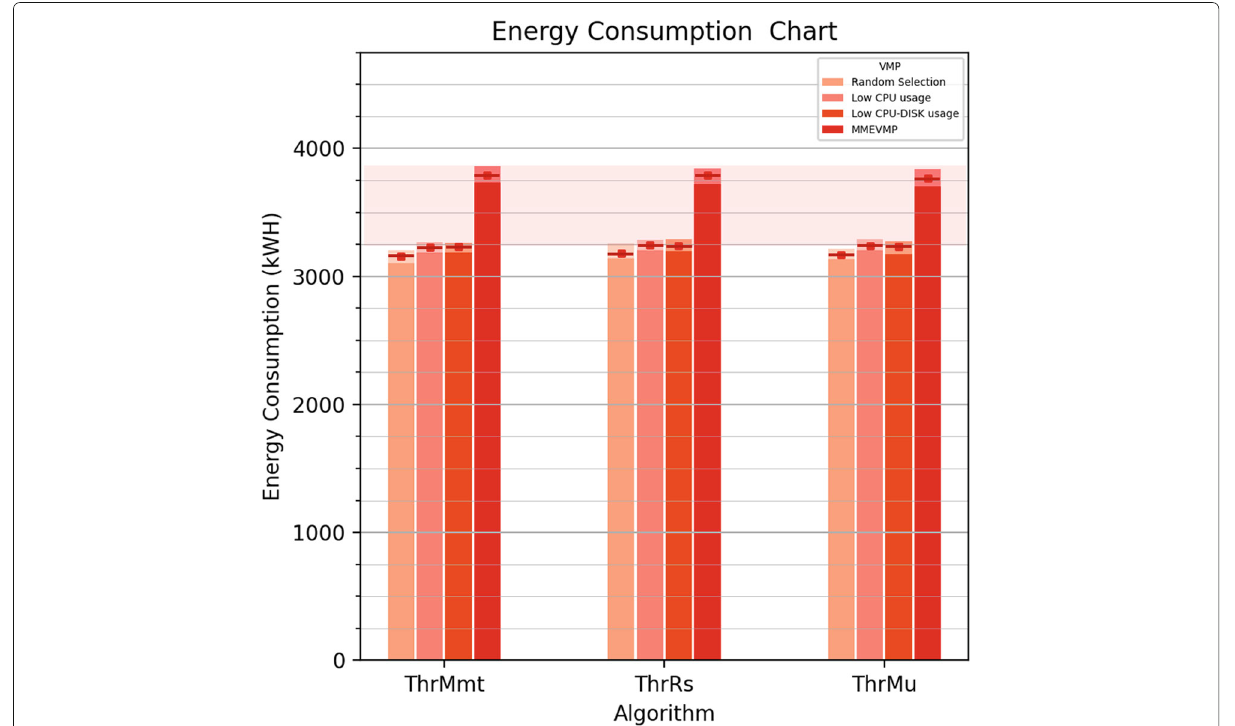
Fig. 11 Energy Consumption Chart. Y-axis refers power utilization per hour